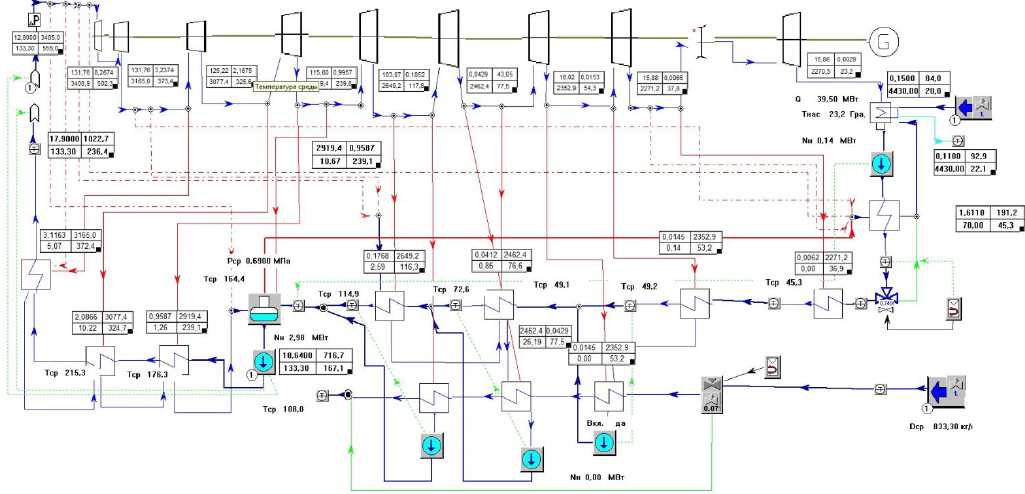
Figure 3. Thermal design with three inline reheaters and quantitative-qualitative heat supply control (uncontrolled extraction).